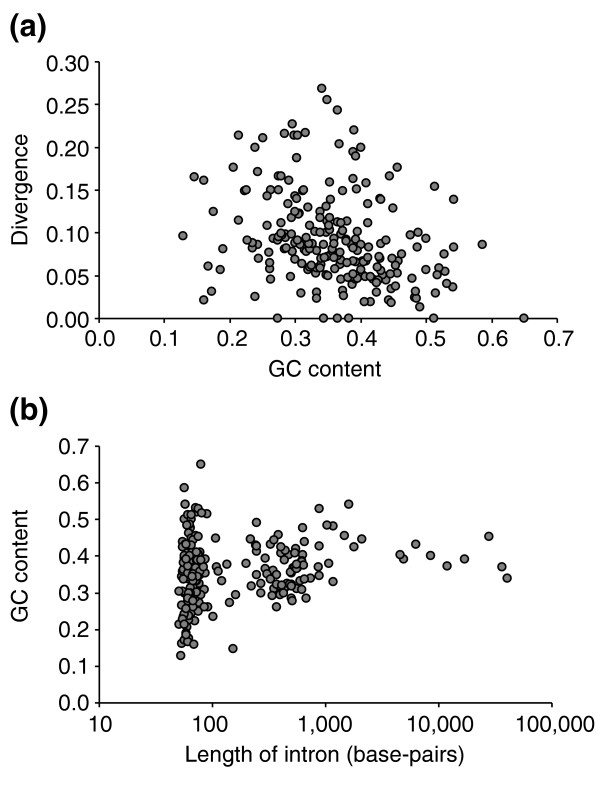
The relationship between intron fragment GC content and both divergence and length. (a) The relationship between GC content of intron fragments and divergence between D. melanogaster and D. simulans (Spearman correlation coefficient Rs = -0.345, P < 10-4). (b) The relationship between GC content of intron fragments and intron length (Rs = 0.237, P < 10-3).